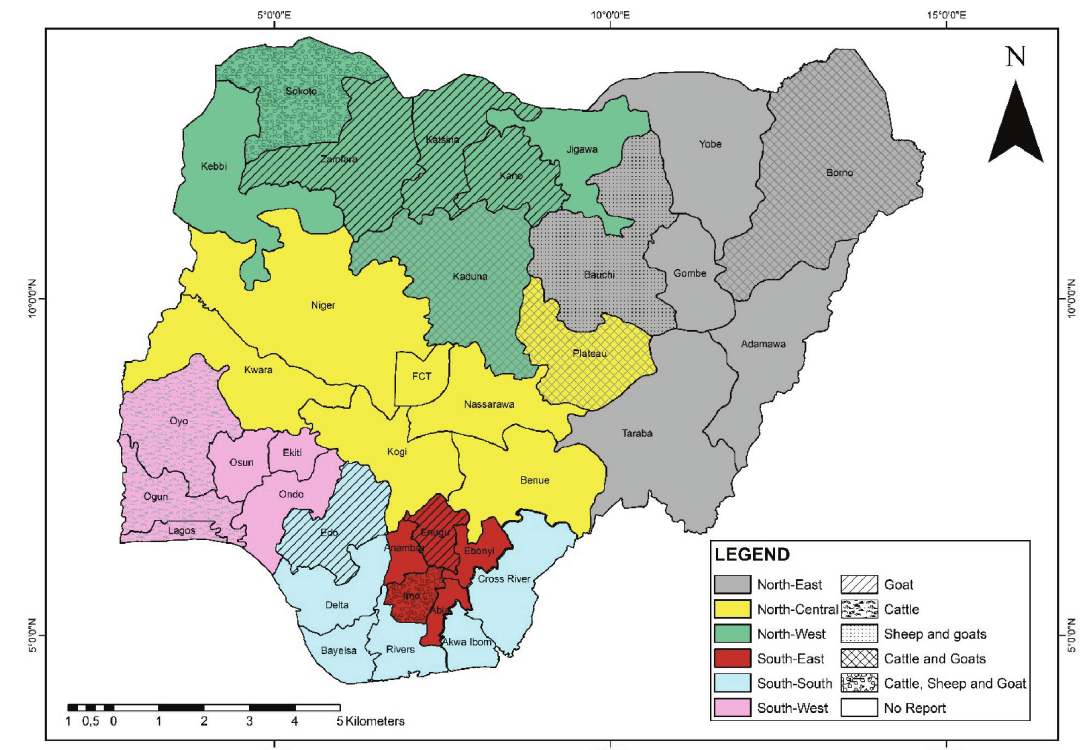
Figure 1 Map of Nigeria indicating areas of Mastitis survey on